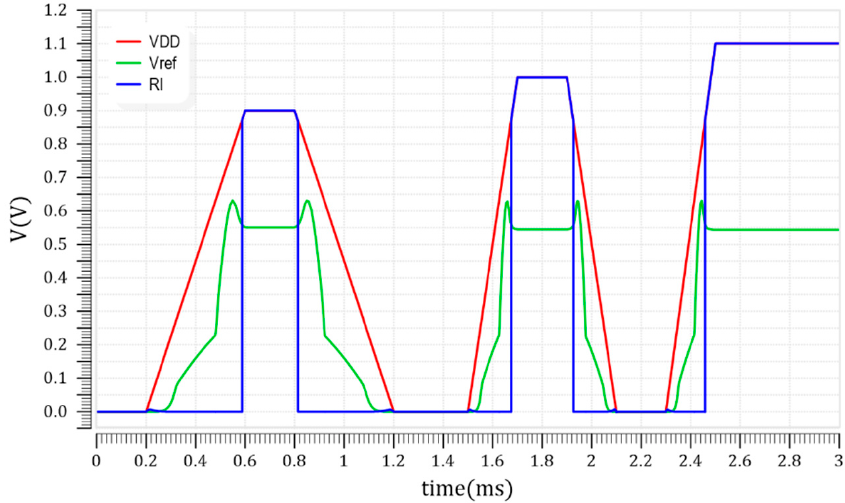
Figure 7. Simulation results for BGR#1 (65 nm, 1 V) in typical temperature (27 °C), 1 V supply volt- age, ±10%.